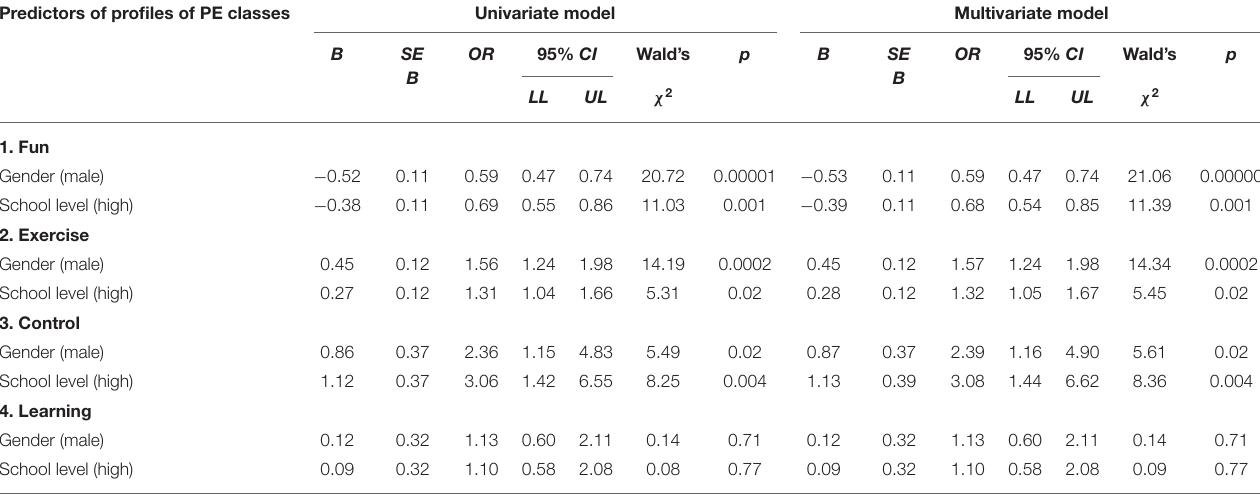
TABLE 3 | Results of the logistic regression analysis predicting preferences for the profiles of PE classes among students ( N = 1,340). Predictors of profiles of PE